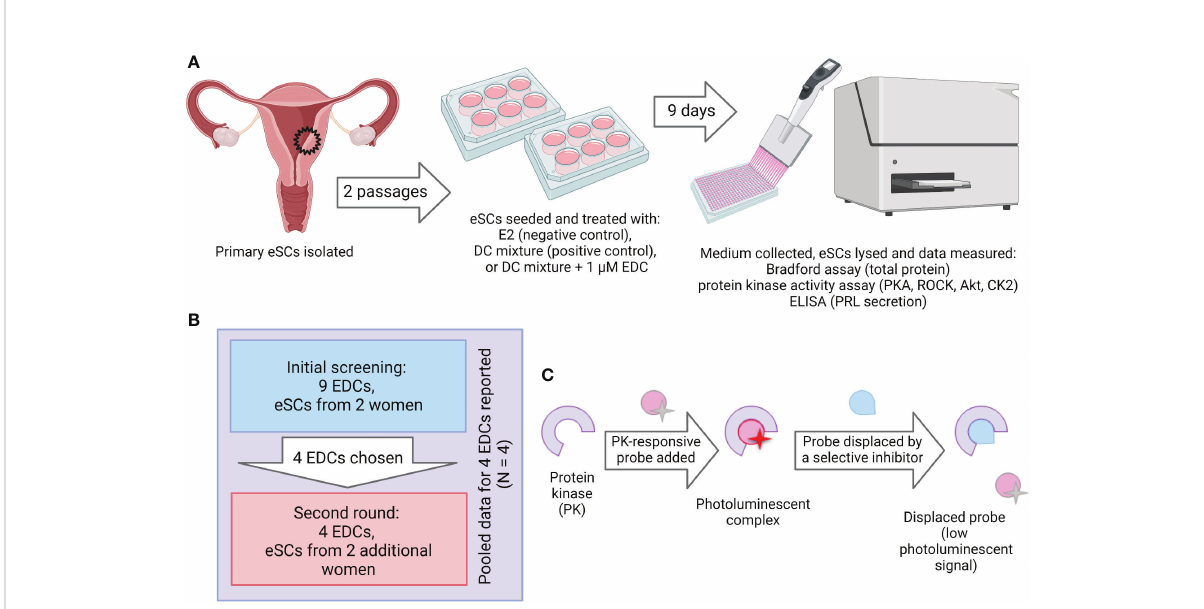
FIGURE 1 Experimental setup. (A) Work fl ow of the decidualization disruption assay. Human endometrial tissue samples were digested to single-cell suspension and endometrial stromal cells (eSCs) were isolated. The eSCs were cultured for two passages before they were cryopreserved for later use in experiments. To induce decidualization, the cells were exposed to decidualization mixture (DC-mix) composed of estradiol (E2), progesterone (P4), 8-Br-cAMP and IBMX for nine days. To test the effect of EDCs on decidualization, the cells were co-exposed to DC-mix and 1 m M of EDCs. Decidualization was assessed by measuring prolactin (PRL) secretion in culture media and activation of protein kinases PKA, ROCK and Akt in lysates of treated cells. Effects on cell proliferation and viability were estimated by the total protein concentration and activity of the viability marker CK2 in lysates of treated cells. (B) Initial screening was performed with nine EDCs on eSCs from two different women. From these nine chemicals, four were chosen for the exposure studies with ESCs from two additional women. (C) The principle of the